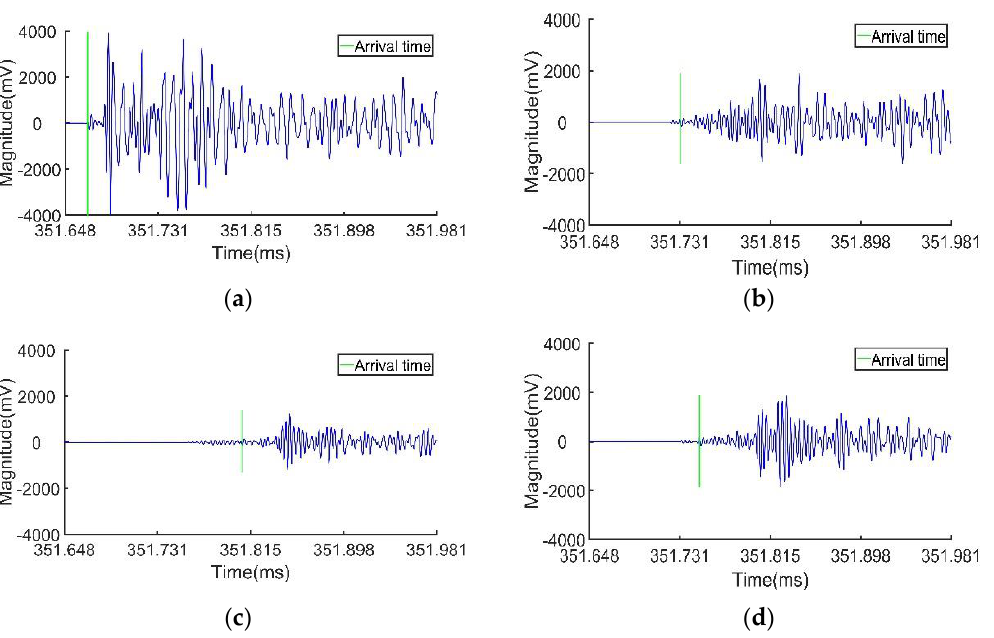
Figure 17. Time-domain impact signals after filtering: ( a ) sensor 1; ( b ) sensor 2; ( c ) sensor 3; ( d ) sensor 4.